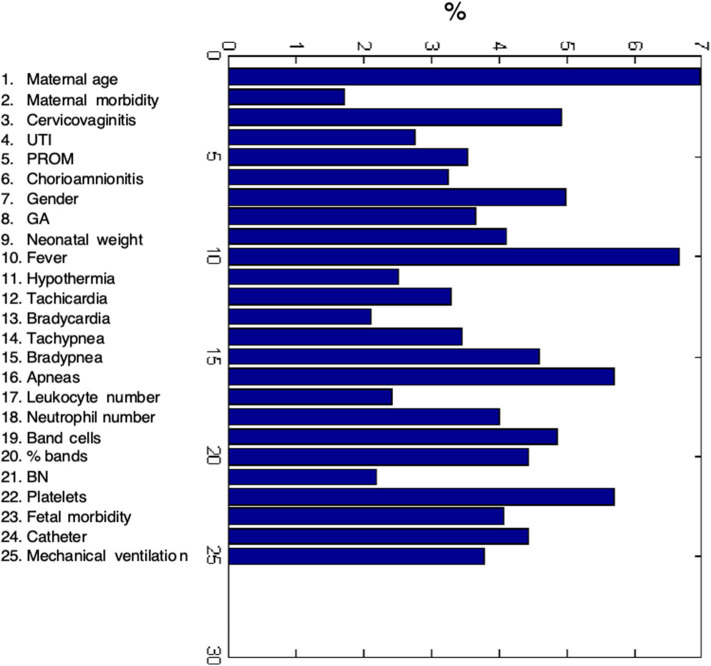
Receiver Operating Characteristics curve of the ANN model.